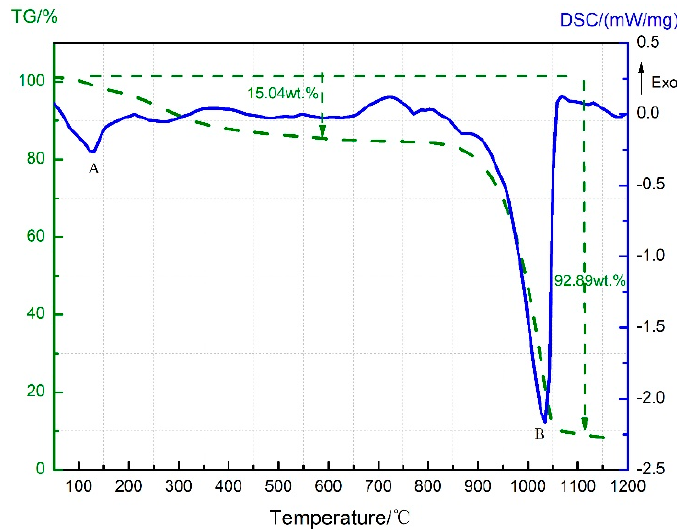
Figure 3. TG-DSC curve of neat AlF 3 .